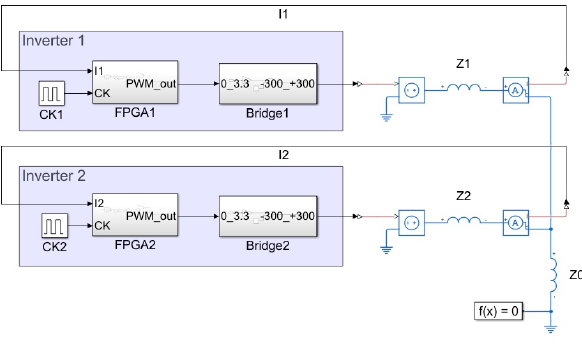
Figure 3. Simulink model of the system with two inverters.